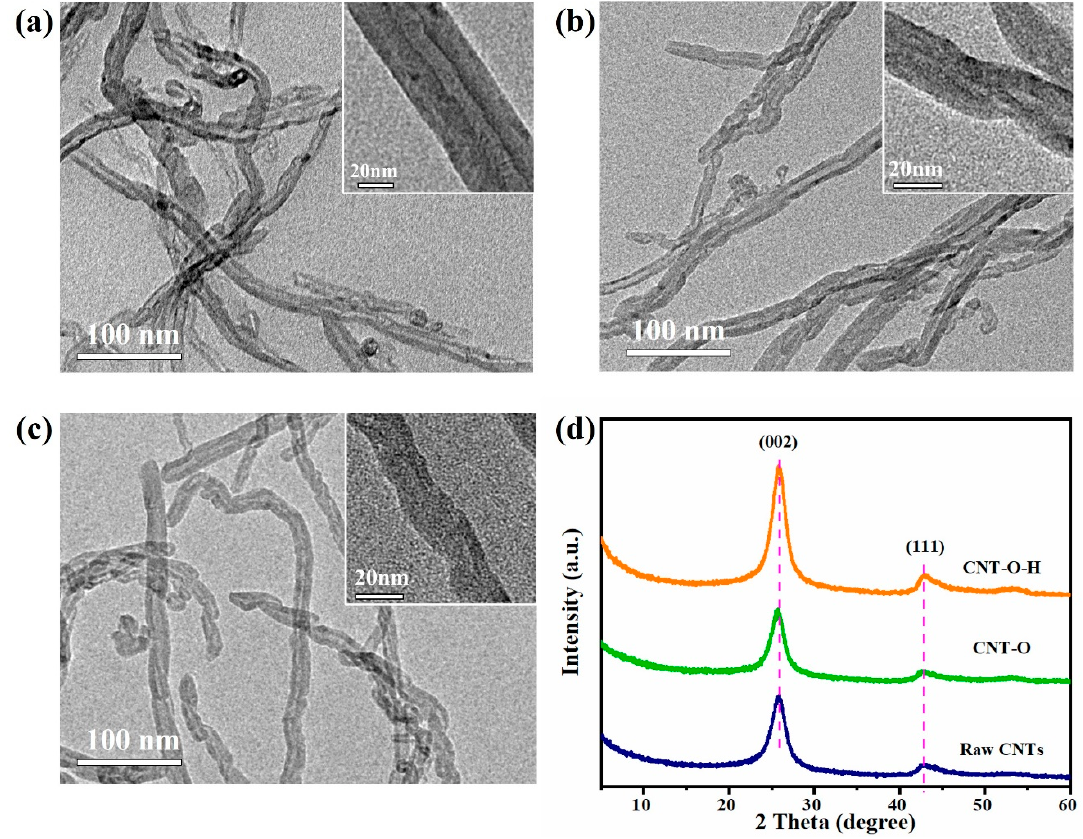
Figure 1. TEM images ( a – c ) and XRD patterns ( d ) of raw CNTs, CNT-O and